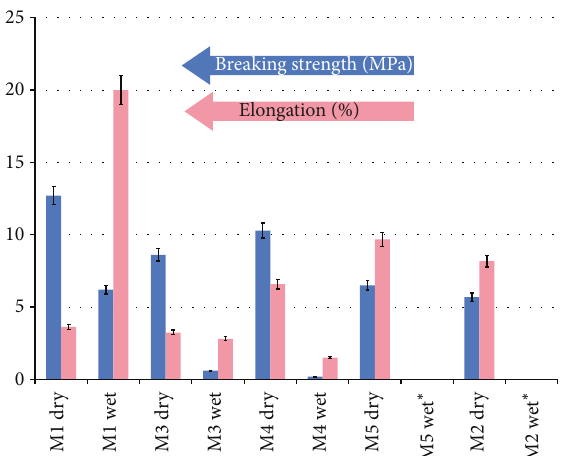
Figure 4: Influence of MCCh and Fb content on breaking strength (Bs) and elongation at break (Eb) of membrane